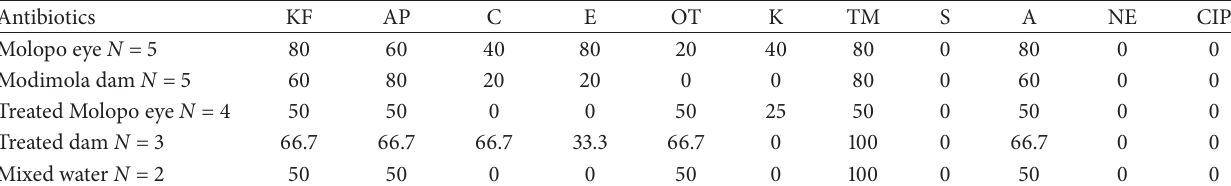
Table 7: Percentage of heterotrophic bacteria resistant to various antibiotics.